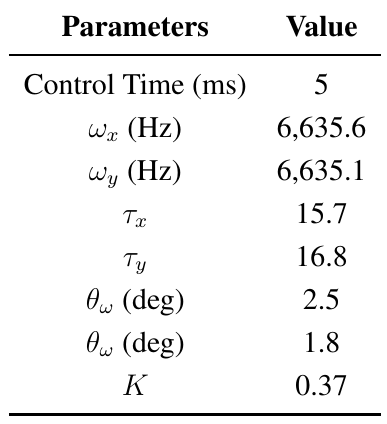
Table 1. The system’s